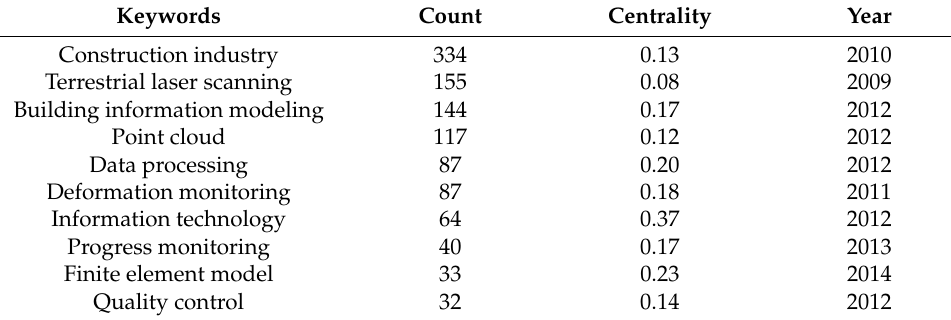
Table 2. List of Top 10 keywords and related network